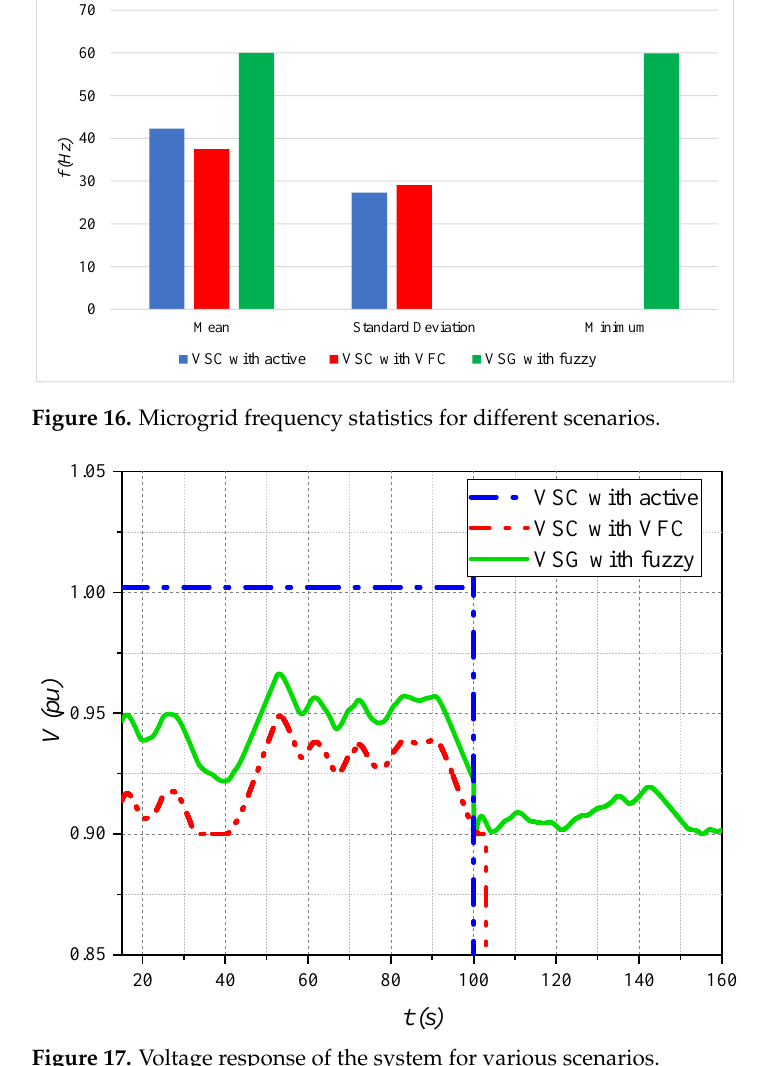
Figure 17. Voltage response of the system for various